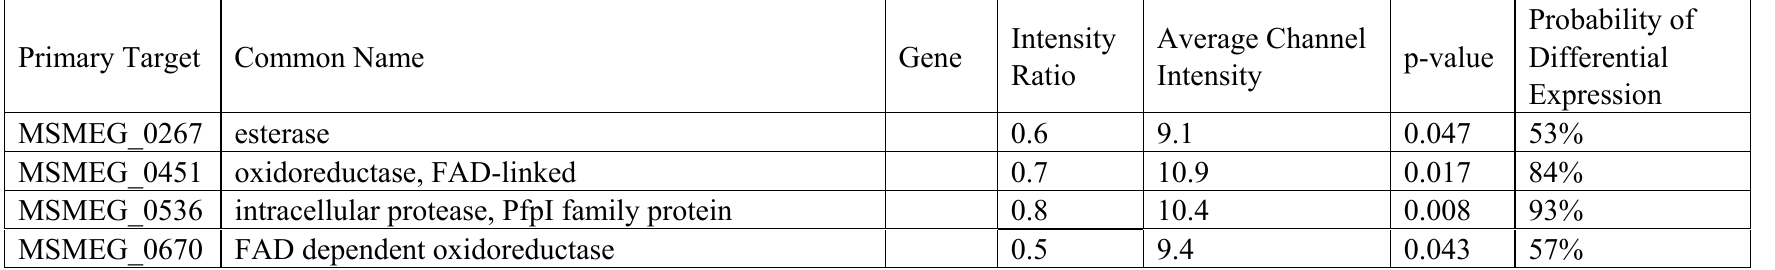
Appendix Table 5. Log phase differential gene expression in multiply cycled bacteria versus non-previously spray dried bacteria (positive expression indicates stationary